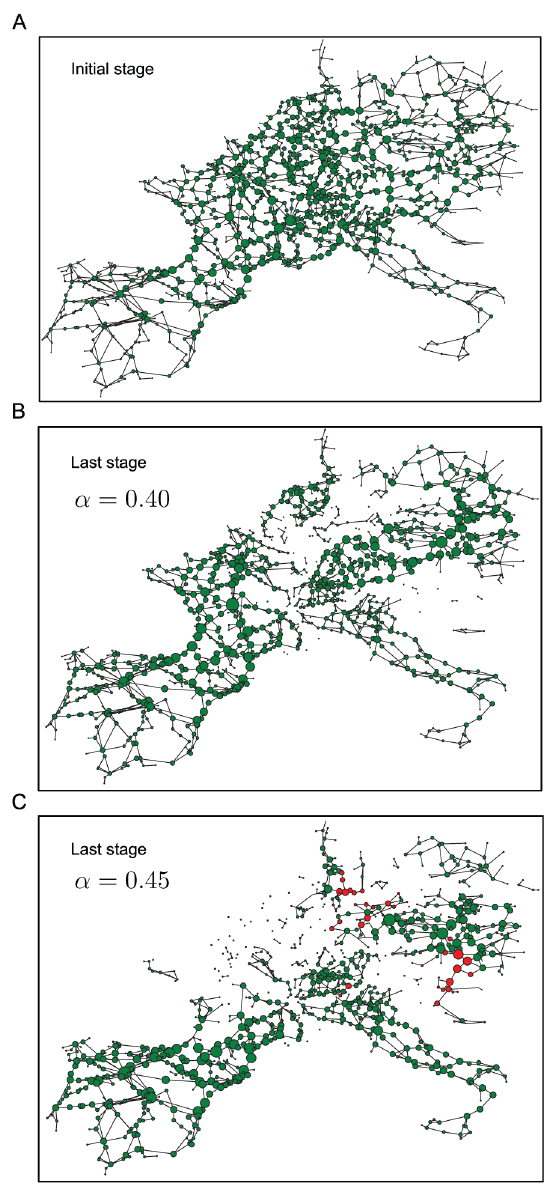
Figure 13. UCTE network snapshots before and after cascades. (A) The intact network with node sizes in proportion to their respective steady-state loads. (B) The network and the loads after a highest-load- removal-triggered cascade has terminated, with the tolerance param- eter a ~ 0 : 40 . (C) The network and the loads after a highest-load- removal-triggered cascade has terminated, with the tolerance param- eter a ~ 0 : 45 . The red nodes here indicate nodes that were removed in the cascade leading to (B), but survived in the cascade leading to (C).